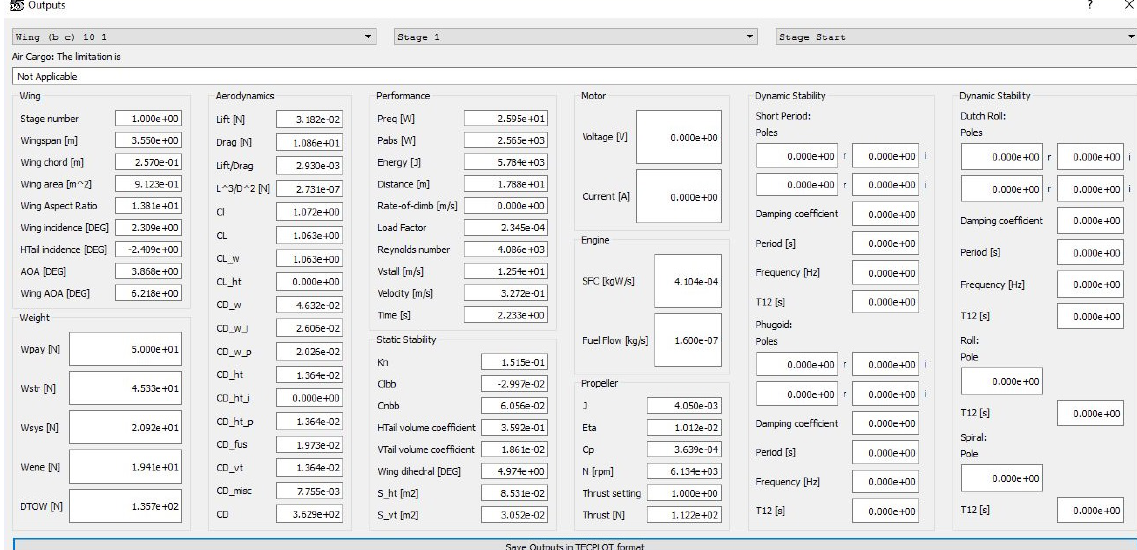
Figure 5: Outputs menu.